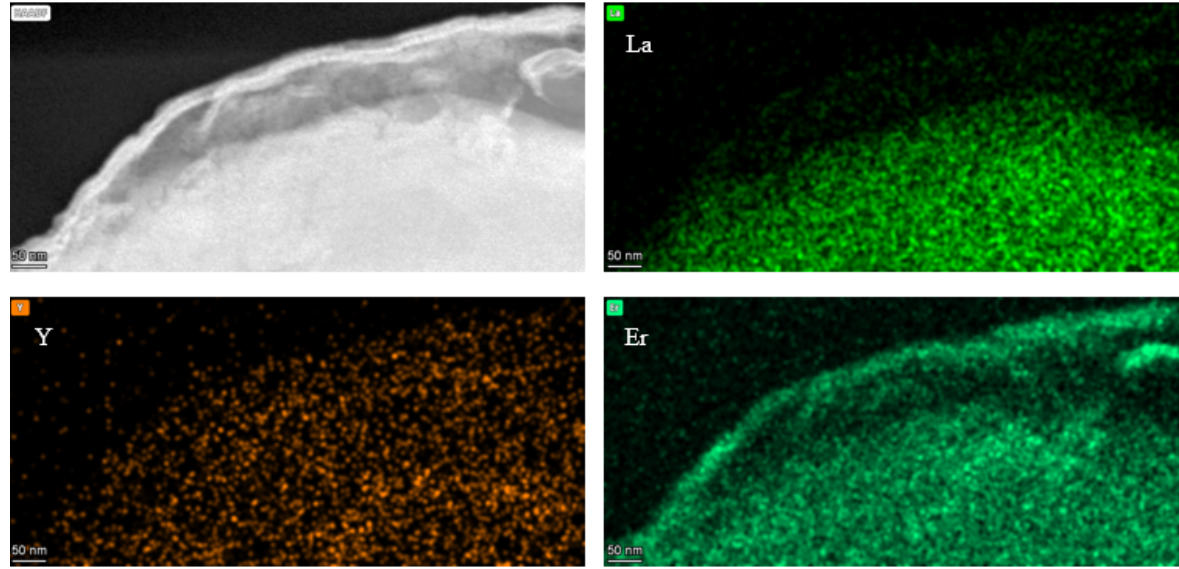
Figure 9. Areas 0940, 1213, and 1003 within a Y- and REE-rich fly ash particle. 1213 is within 940. The locations of Figures 17 and 18 are shown. HAADF (high-angle annular dark-field) image. Areas 1213, 0940, and 1158/1201